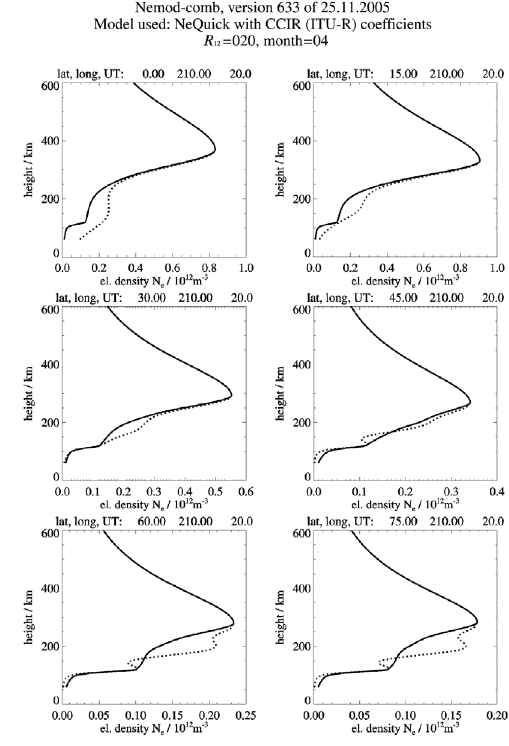
Fig. 6. Height profiles of electron density: April; R 12 = 20; 20 h UT; geografic longitude 210°E; 10 h LT; geografic latitudes 0°N ( top left ) to 75°N ( bot- tom right ); latitude spacing 15°. Solid curves: re- vised NeQuick, dotted curves: NeQuick, old formu-